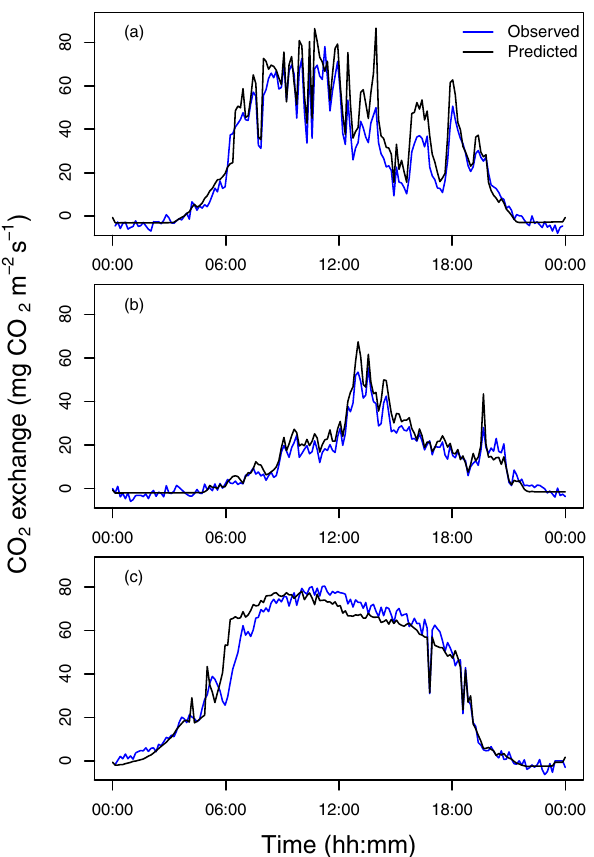
Figure 3. Measured and predicted leaf CO 2 exchange (a) during a day of intermittent cloudiness (5 August), (b) during a cloudy day (22 July), and (c) during a sunny day when the stomata close partially (7 July) in Finnish Lapland, 68 ◦ N.